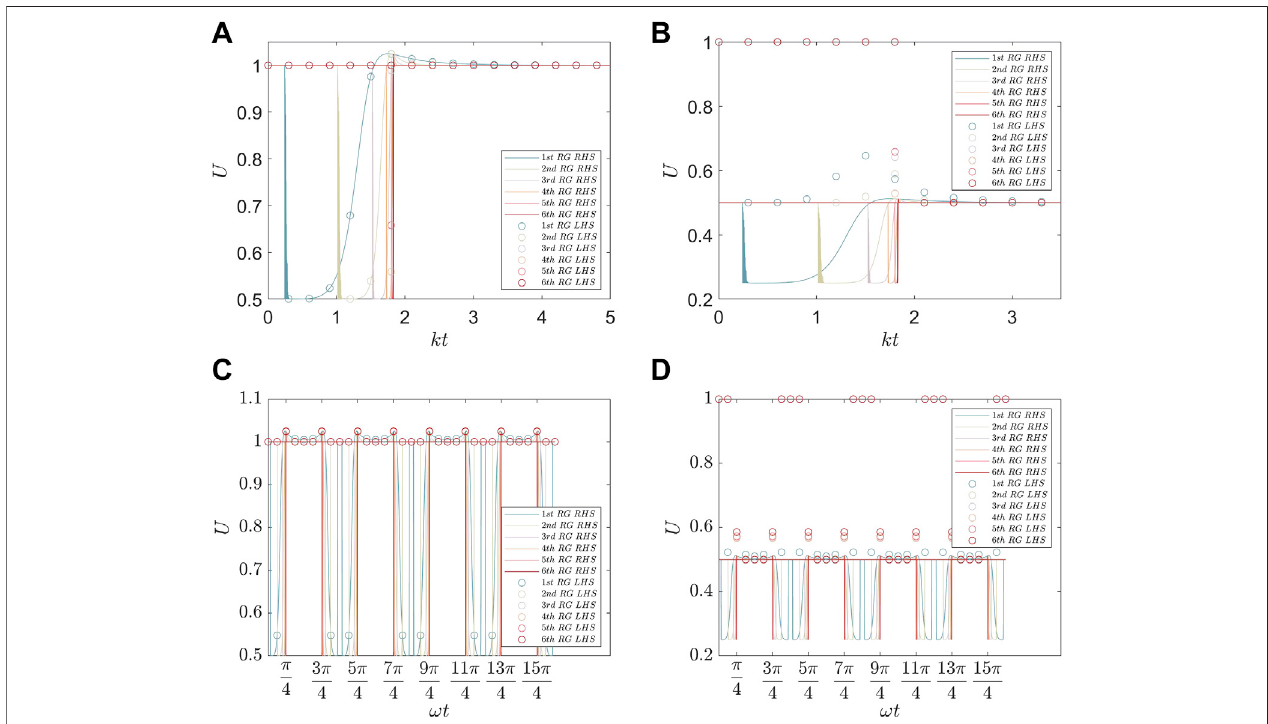
FIGURE 5 | The evolution of the uncertainty of the 2D Ising model. The uncertainty equality (A) and inequality (B) versus kt with the magnetic fi eld B 3 ( t ), the uncertainty equality (C) and inequality (D) versus ω t with the magnetic fi eld B 4 ( t ).